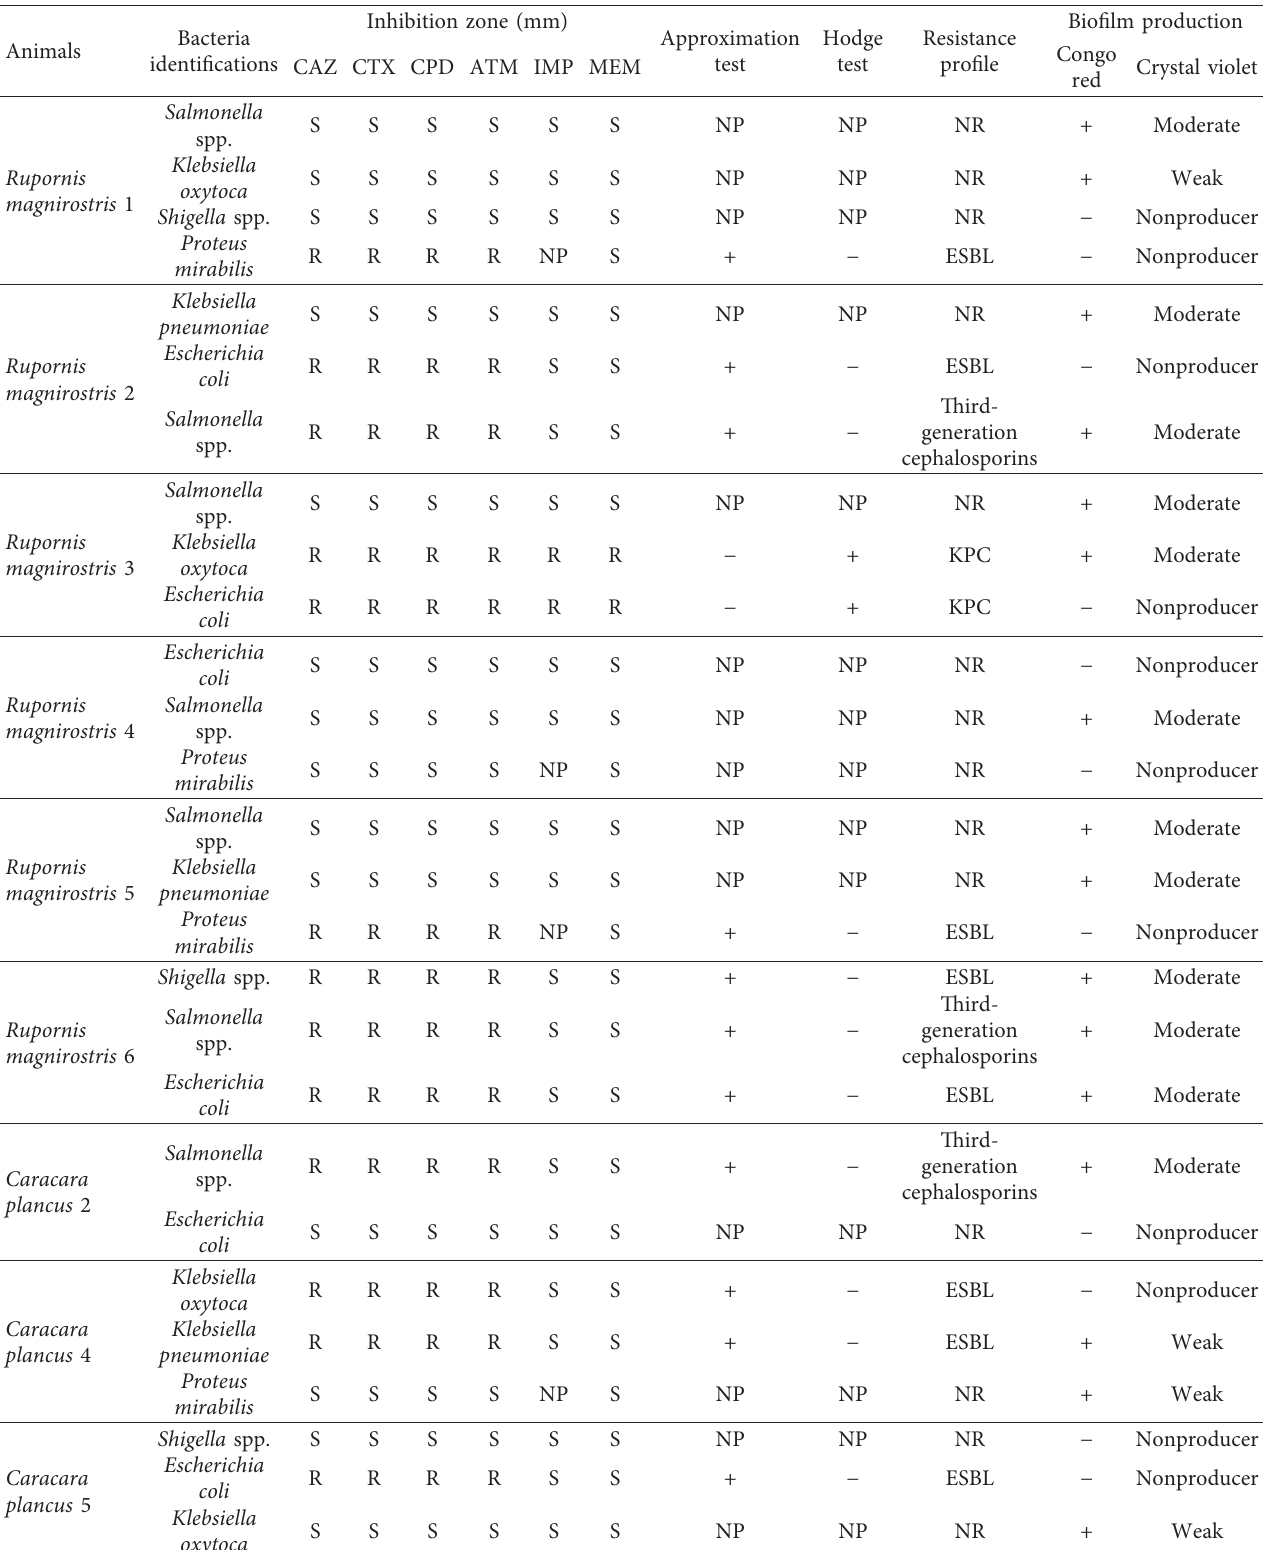
Table 2: Resistance profile and biofilm production of Enterobacteriaceae isolated from oropharynx of Rupornis magnirostris and Caracara